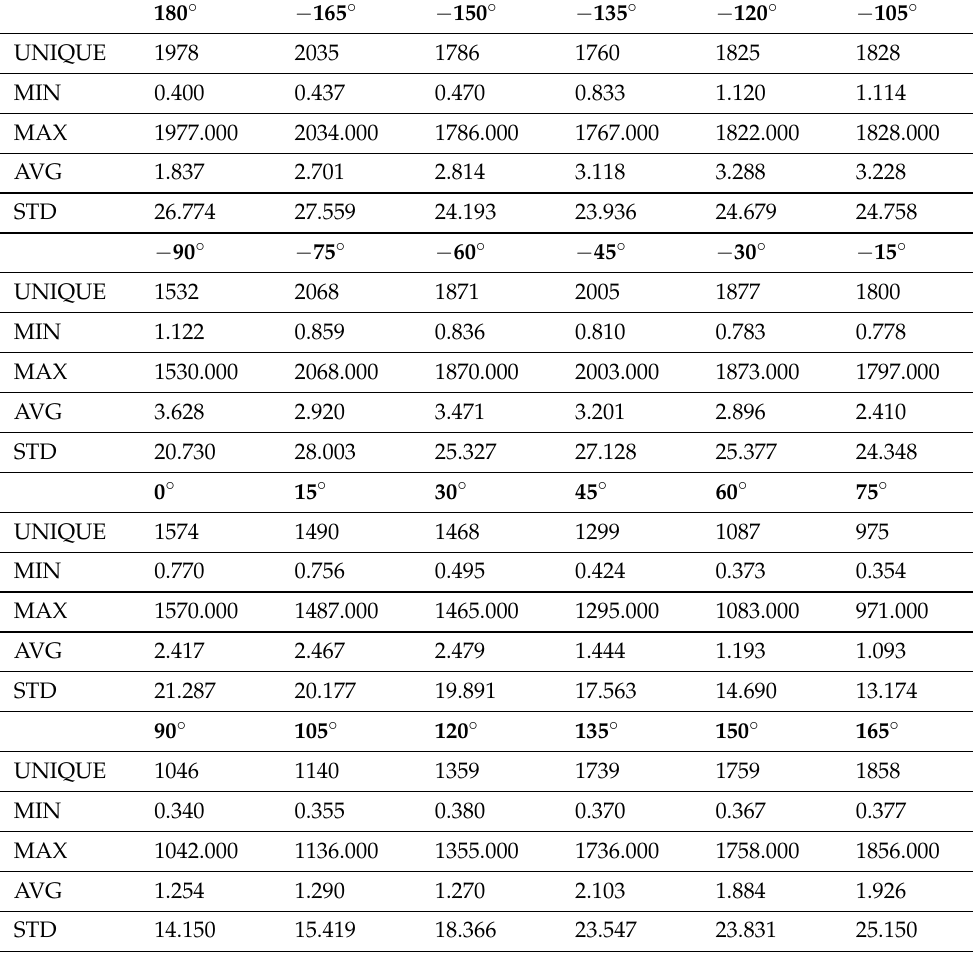
Table 1. The descriptive statistics of the used